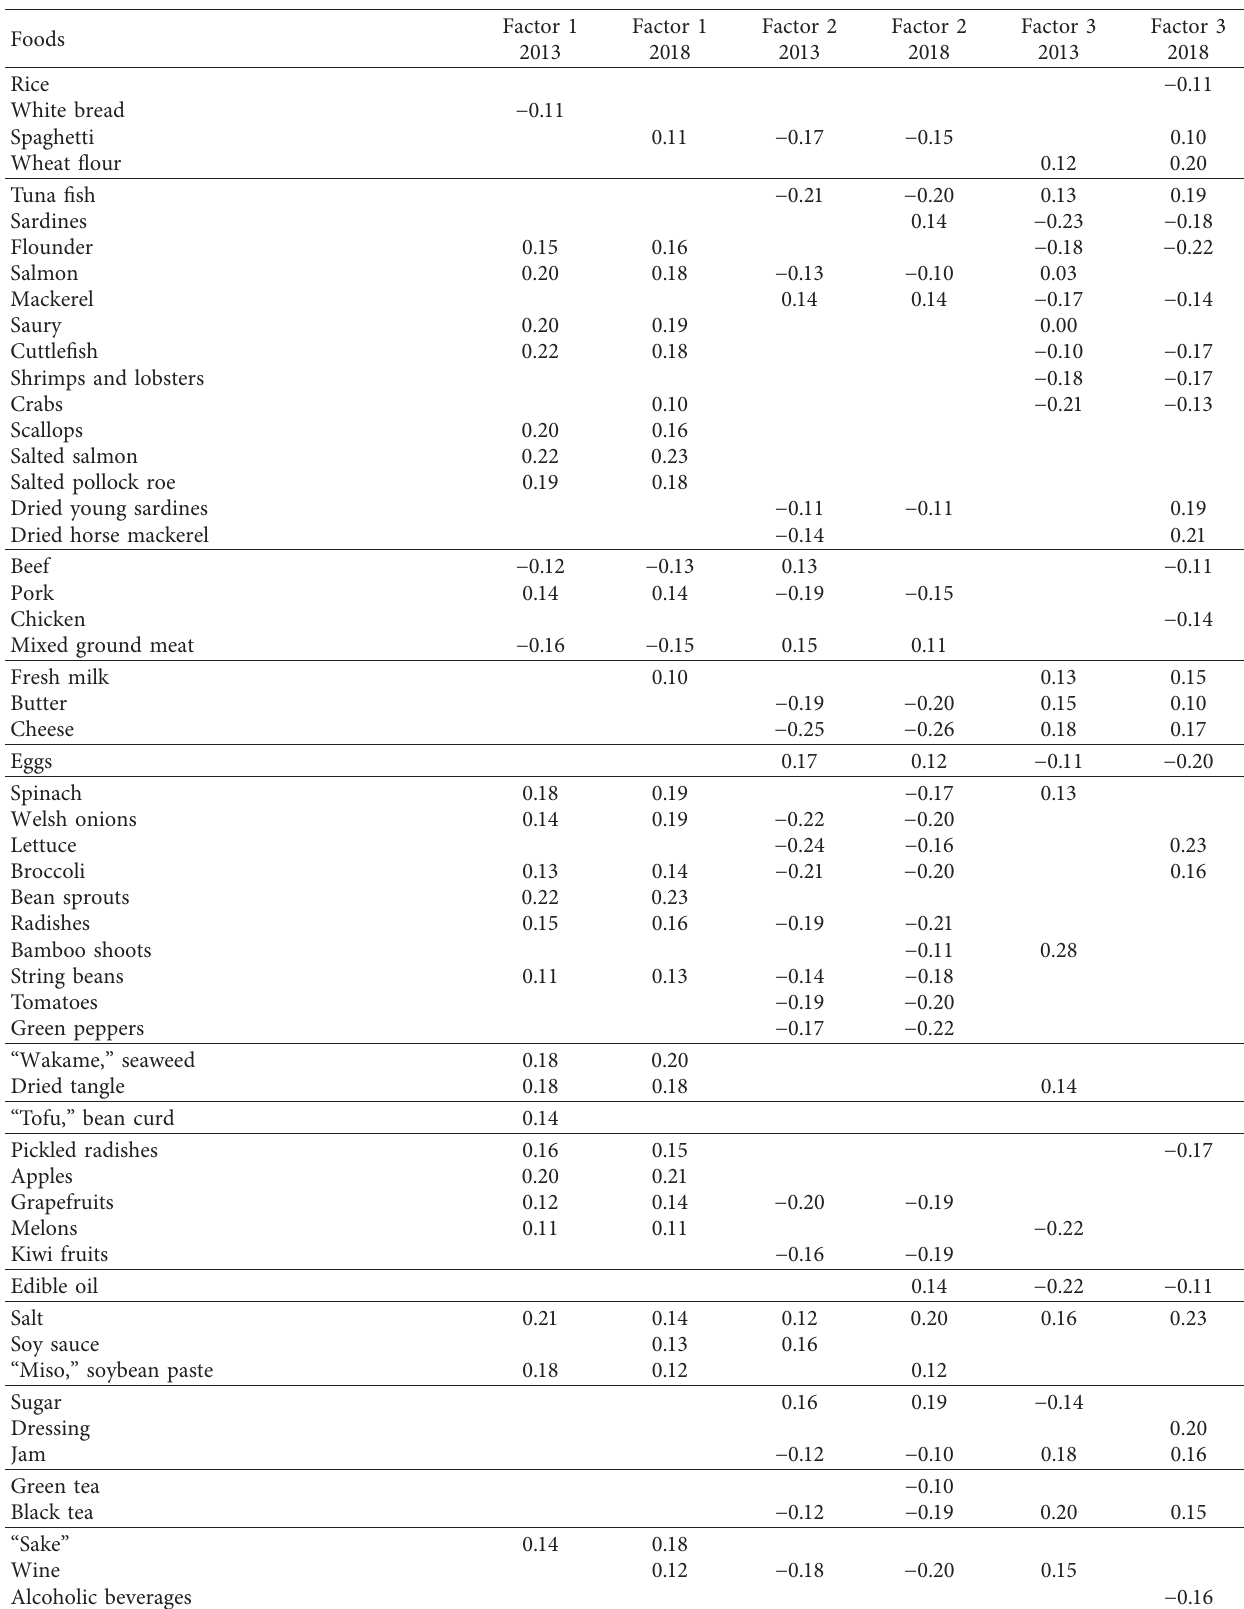
Table 4: Factor loadings of food groups in dietary patterns identified using PLS regression